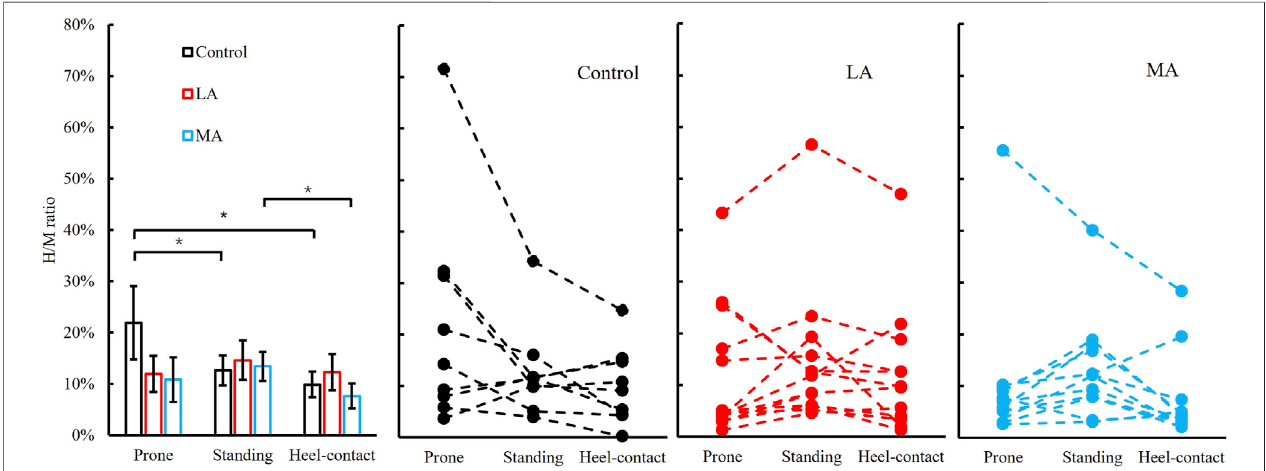
FIGURE 3 | Left panel: H/M ratio (Mean ± SEM) of three postures (prone-solid line, standing-dash line, and heel-contact-dotted line) among three groups (control, LA, and MA). * indicates a statistically signi fi cant difference among postures in the same group. Right three panels: individual data points in control, LA, and MA groups are presented for all three